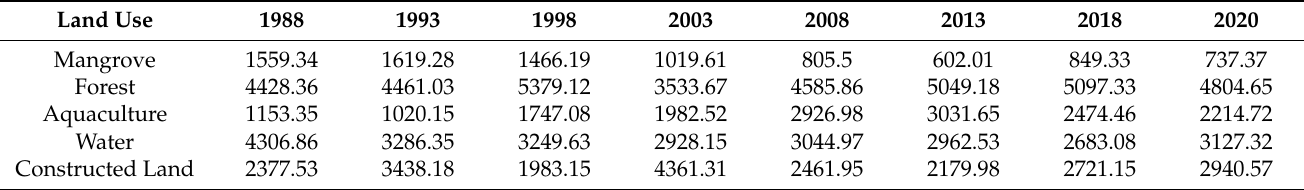
Figure 2. Spatial distribution of land use in the coastal zone of Qinglan Bay from 1988 to 2020. Table 4. Dynamic changes in mangrove area of the Qinglan Bay from 1988 to 2020 (ha).